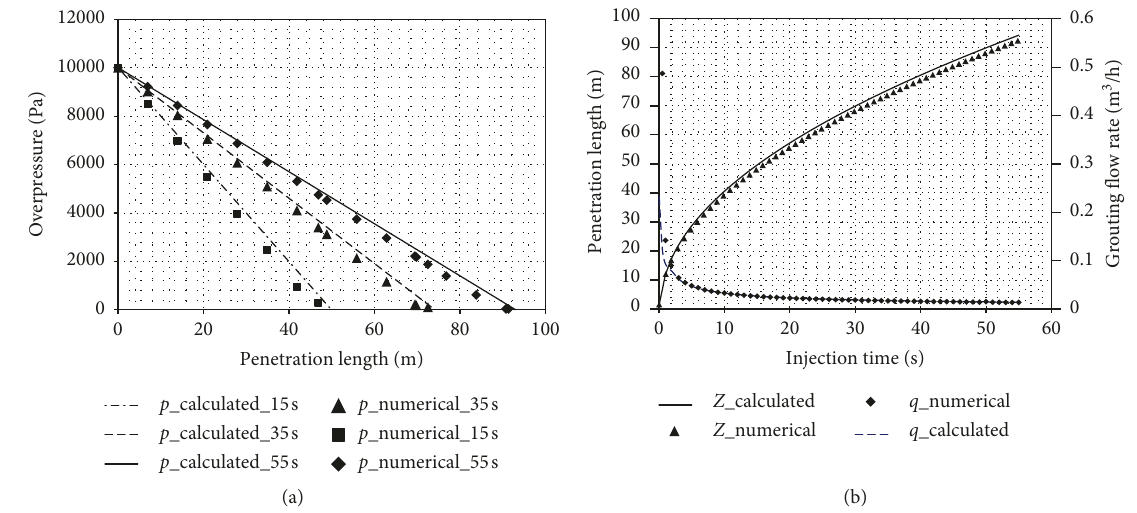
Figure 9: Comparisons of prediction and numerical simulation results under constant grouting pressure conditions. (a) Overpressure distribution in the grouted zone for the CG at three grouting times, 15, 35, and 55s. (b) Variations in penetration and grouting flow rate with injection